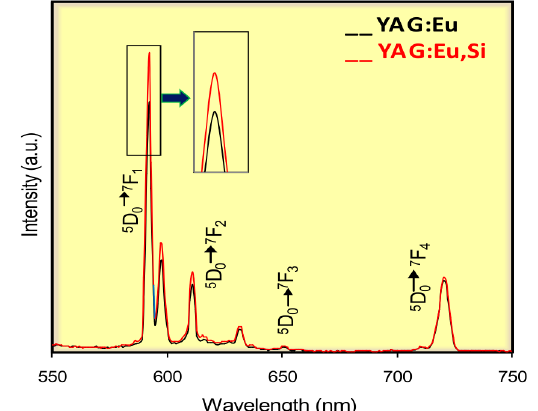
Fig. 8 Comparison of emission spectra of Y 3  x Eu x Al 5 O 12 ( x = 1) and Y 3  x Eu x Al 5  y Si y O 12 ( x = y =